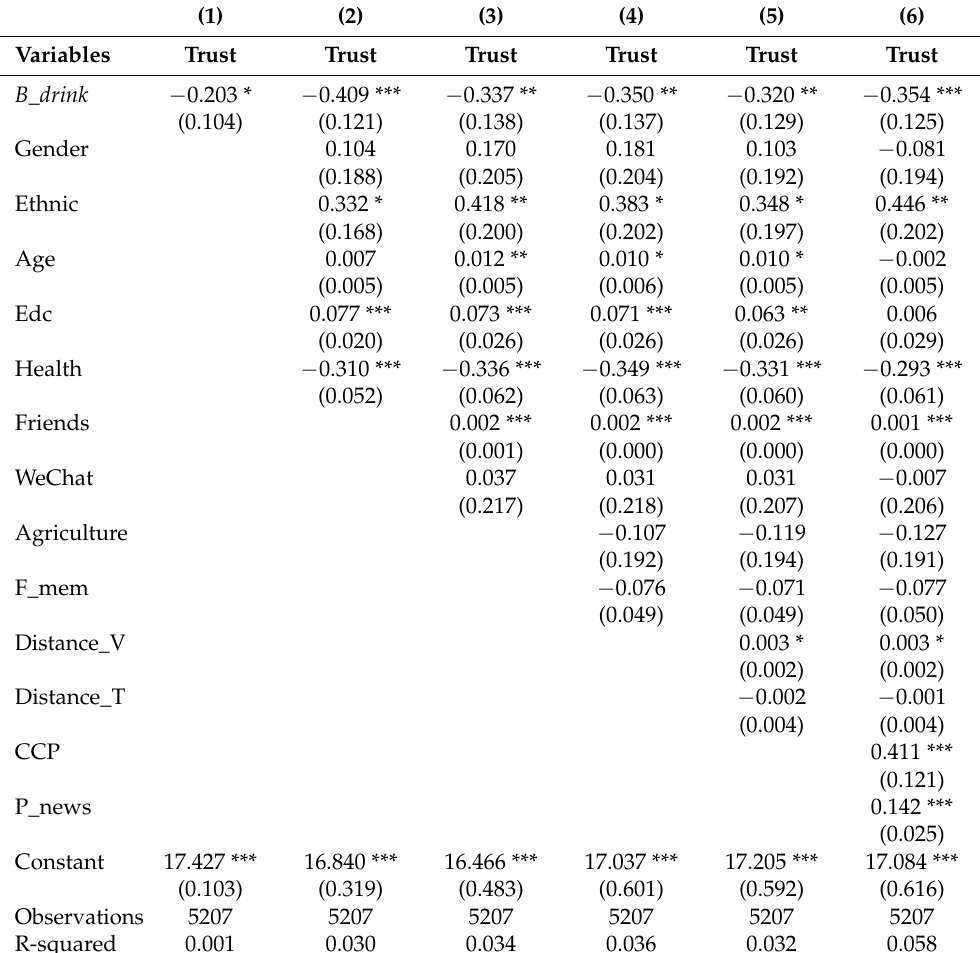
Table 4. The results of baseline